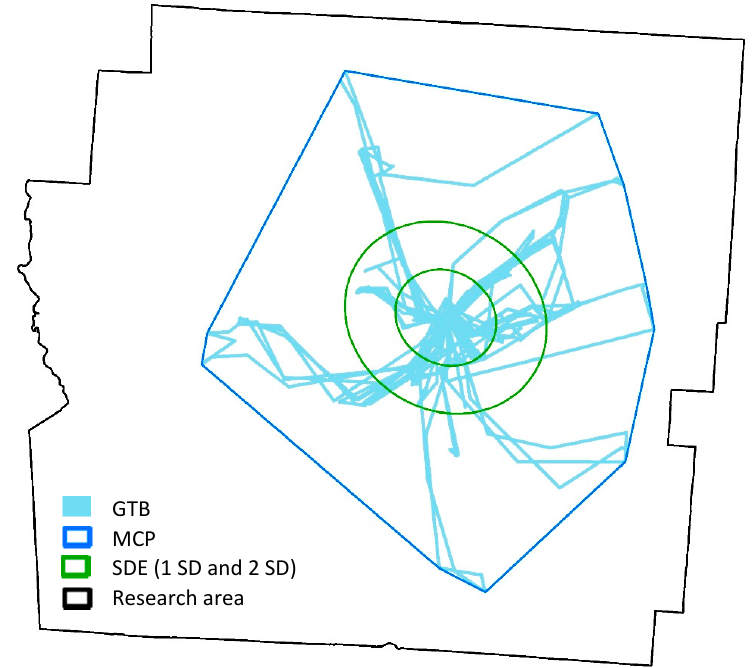
Figure 8. Four widely used methods for delineating individual exposure space based on one subject’s GPS trajectory data.